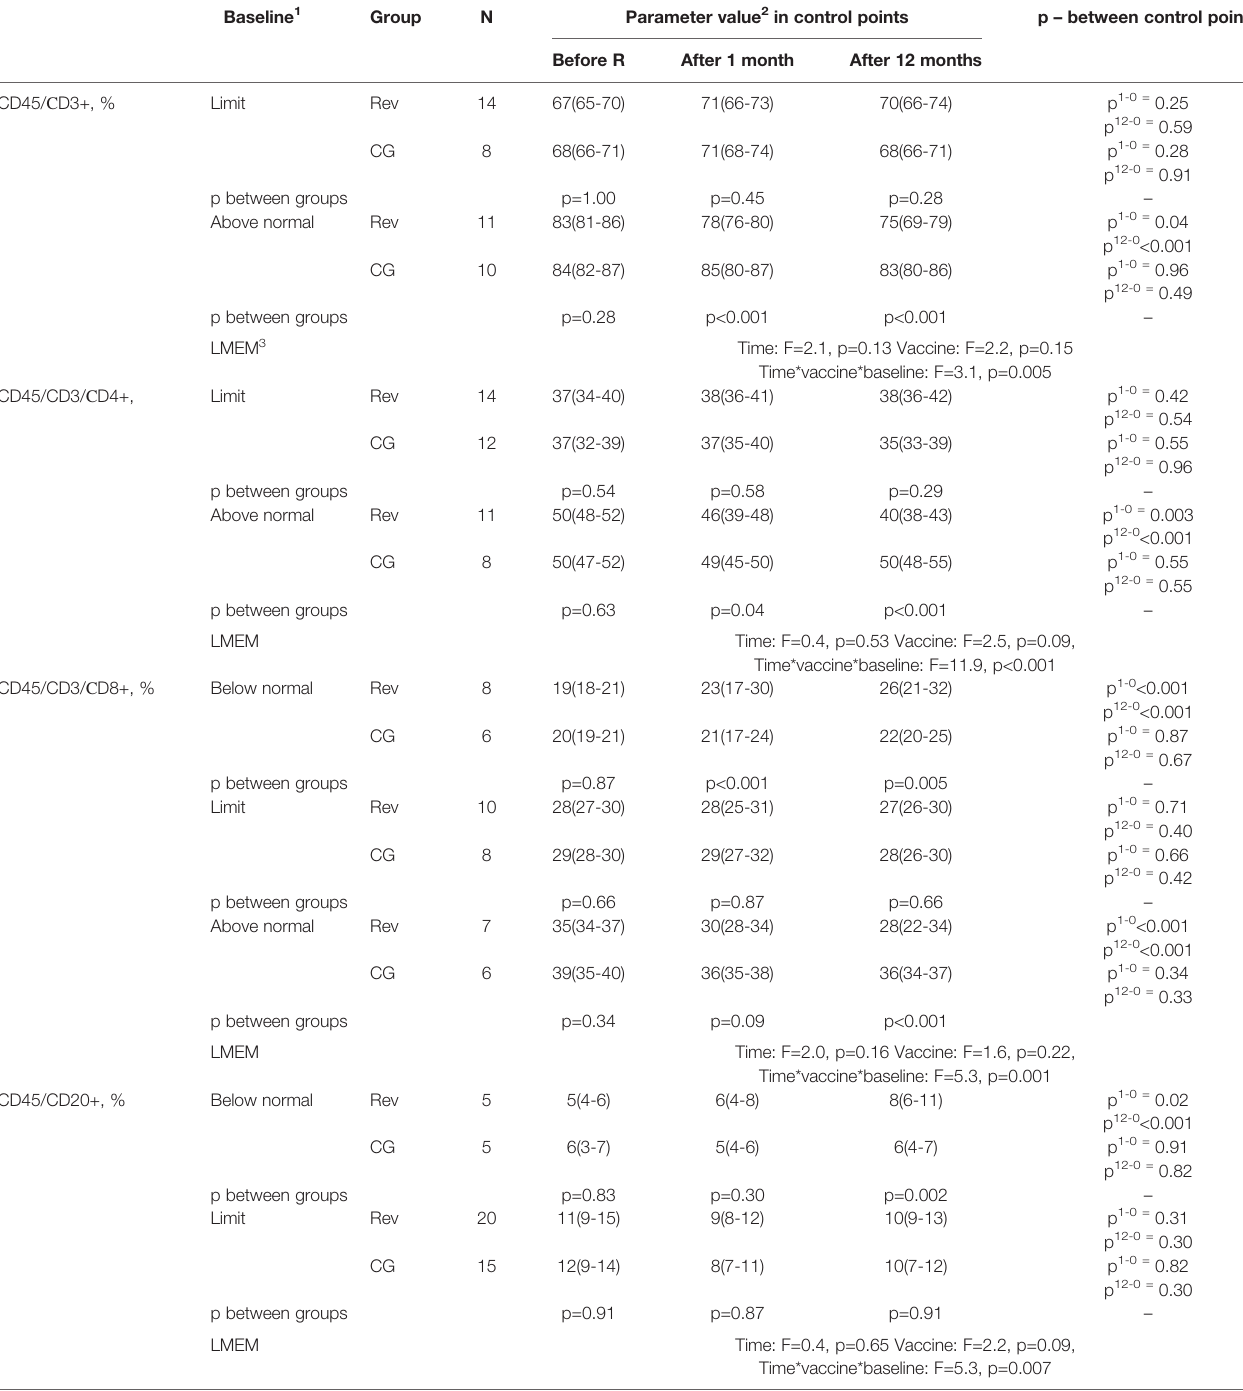
TABLE 4 | Dynamics of the subpopulation structure of peripheral blood lymphocytes in children with GN after revaccination with DT toxoid and the control